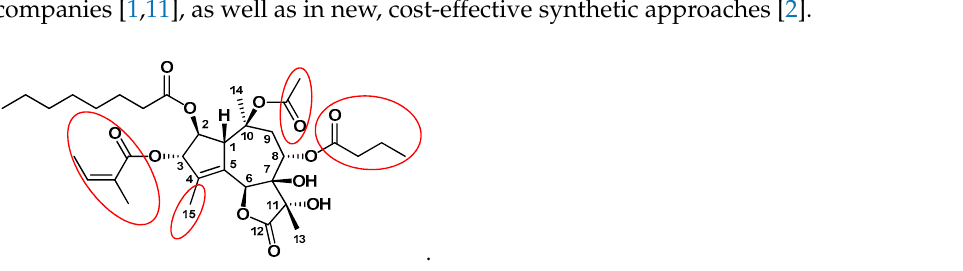
Figure 1. The chemical structure of Tg. Pharmacophoric groups important for biological activity are marked in red circles.